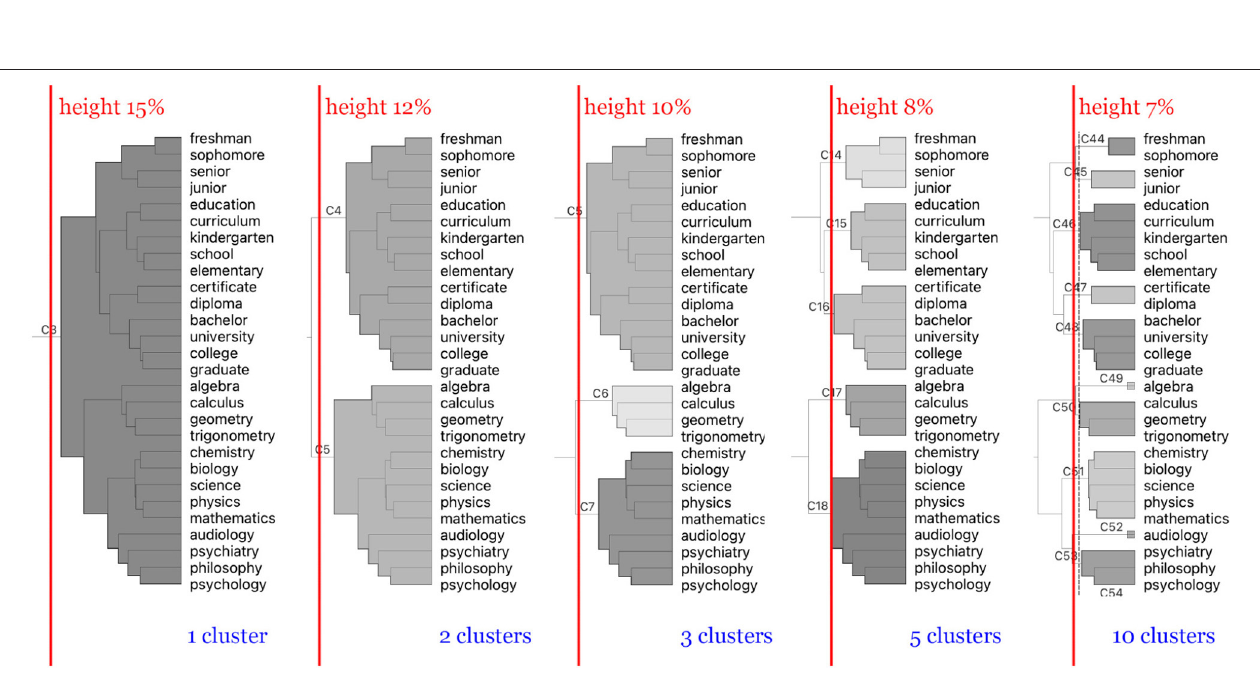
FIGURE 4 | Pairwise comparisons in 100-dimensional GloVe vectors in ASL (left) and BSL (right) . Each point is a pair of signs [s1, s2] ; x -axes show phonological similarity, y -axes show semantic similarity.